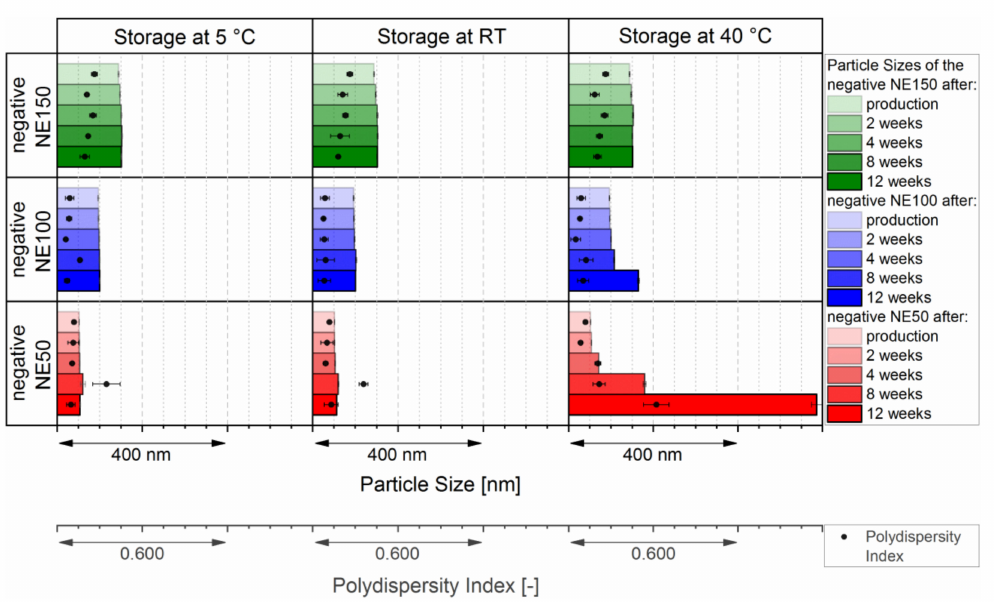
Figure 5. Long-term stability of the three negatively surface-charged nanoemulsions at the recom- mended storage conditions according to the ICH guidelines Q1A of 5 ± 3 ◦ C, room temperature (RT), and 40 ± 2 ◦